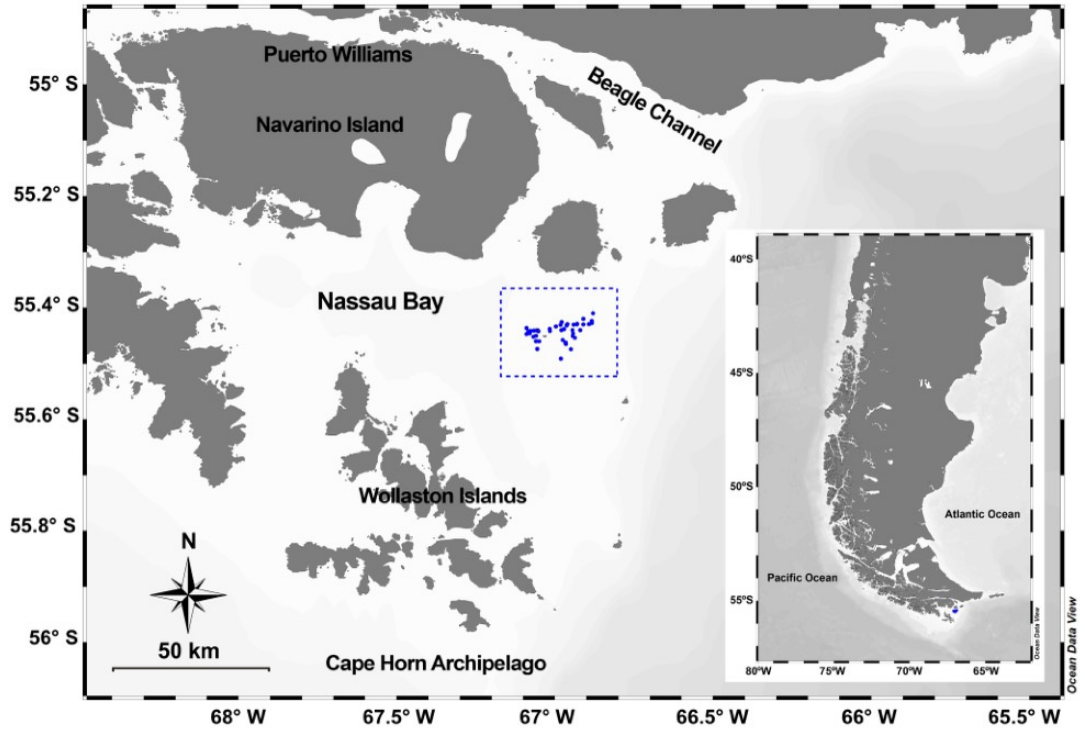
Figure 1. Map showing the sampling locations where southern king crab Lithodes santolla , their primary food sources, and associated fauna organisms were collected in Nassau Bay, Cape Horn.